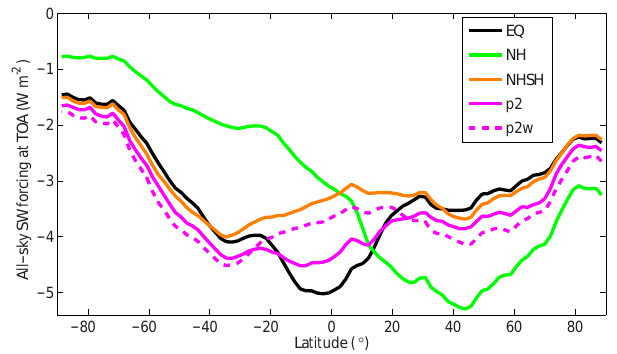
Figure 4. The 5-year zonal means of all-sky shortwave radiative forcing in selected